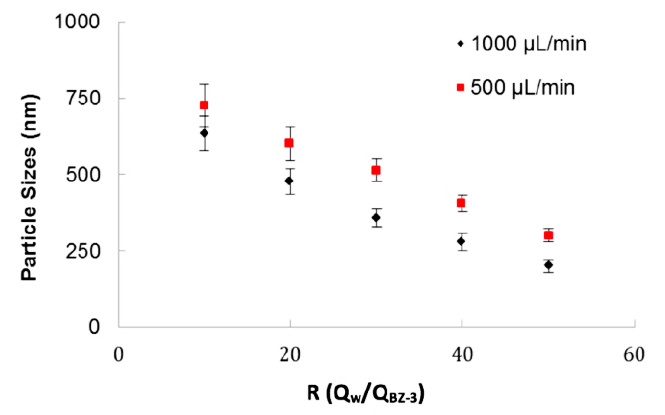
( c ) Figure 4. Sodium alginate microparticles: ( a ) sodium alginate droplets before ionic gelation, ( b ) sodium alginate microparticles after ionic gelation, and ( c ) the 3D coaxial device in operation. White bar scale of 200 μ m. It is important to note that the geometry used to make the 3D coaxial structure allow the production of water-in-oil emulsions without surface treatment. 3.1.2. Benzophenone-3 (BZ-3) Nanoprecipitation Benzophenone was diluted in two solvents: Isopropyl Alcohol and Methanol in order to process Benzophenone in nanoparticles synthesis. The Benzophenone concentration used was 7.5 mg/mL, defined in previous experiments. Ultra-pure water was used as anti-solvent in this process as a continuous phase. Again, syringe pumps controlled both fluids. Particles were evaluated by DLS equipment. The 3D-FFD device was also used to produce particles by nanoprecipitation process. Figure 5 shows the particle size relation with ratio between fluid flows ( R = Q water / Q B-3 ) for two water flow rates ( Q water ) of 1000 μ L/min and 500 μ L/min. This ratio ( R ) indicates how many times the continuous phase flow is higher than the dispersed phase. The higher the term R is, the smaller the droplet size gets. It was observed that total flow rate influences the final particle size. In this example, it was verified that for a flow rate of 500 μ L/min the particle sizes are higher than for 1000 μ L/min. As